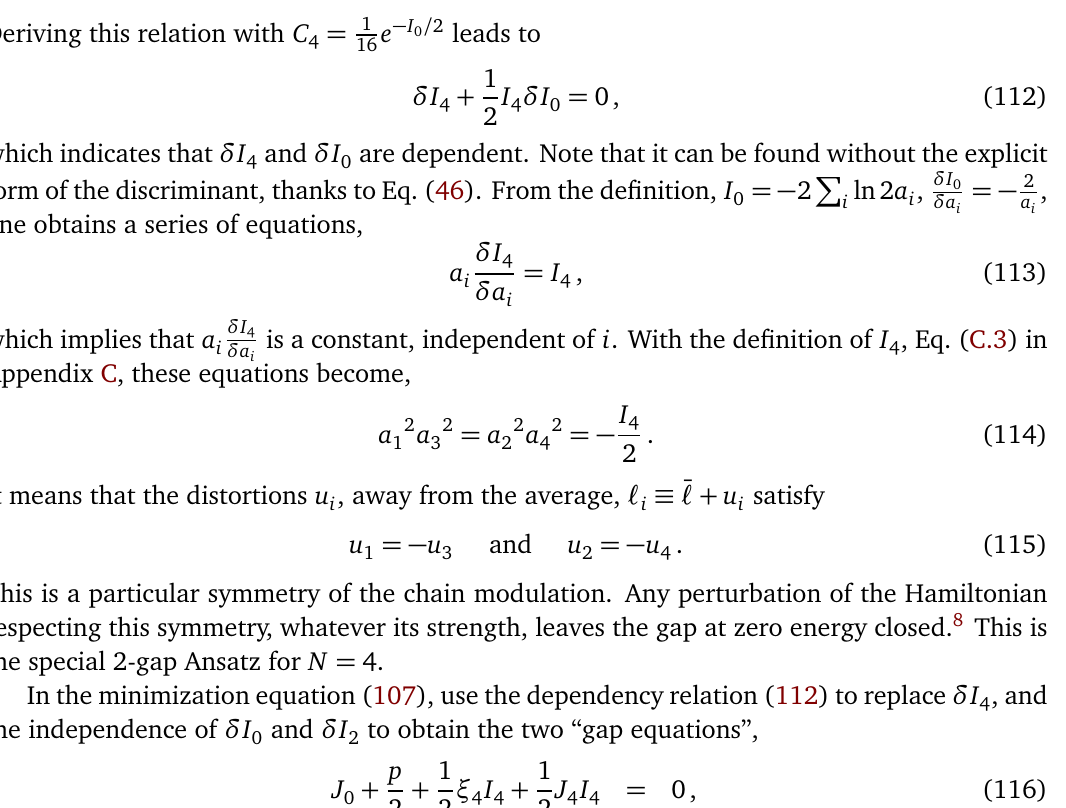
Figure 5: Regions of existence for the various phases at c = 1 / 4: the 3-gap phase exists only in the grey area. The 2-gap phase exists everywhere except in the “no > 0 for all i , are not fulfilled. The 0-gap solution” region where the constraints, ℓ i phase (not shown) exists wherever the other phases exist. Here, p =